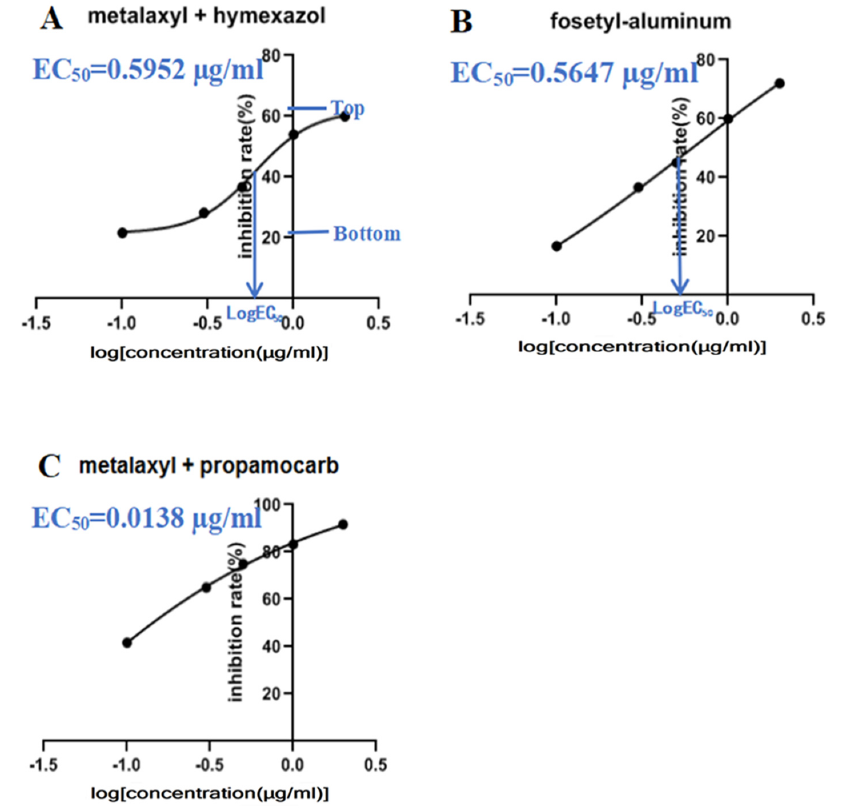
Figure 5. Three-parameter log-logistic estimated EC 50 values for Pythium aristosporum isolate, chal- lenged against common chemical fungicides used to manage rice seedling blight in Northeast China.